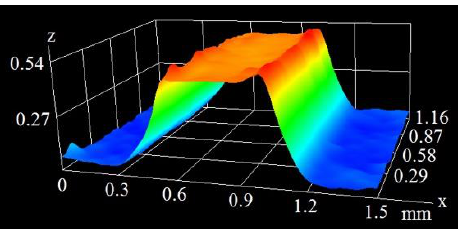
Figure 6. The image of a microfin from a pulse duration of 120 ns and velocity of 400 mm/s.